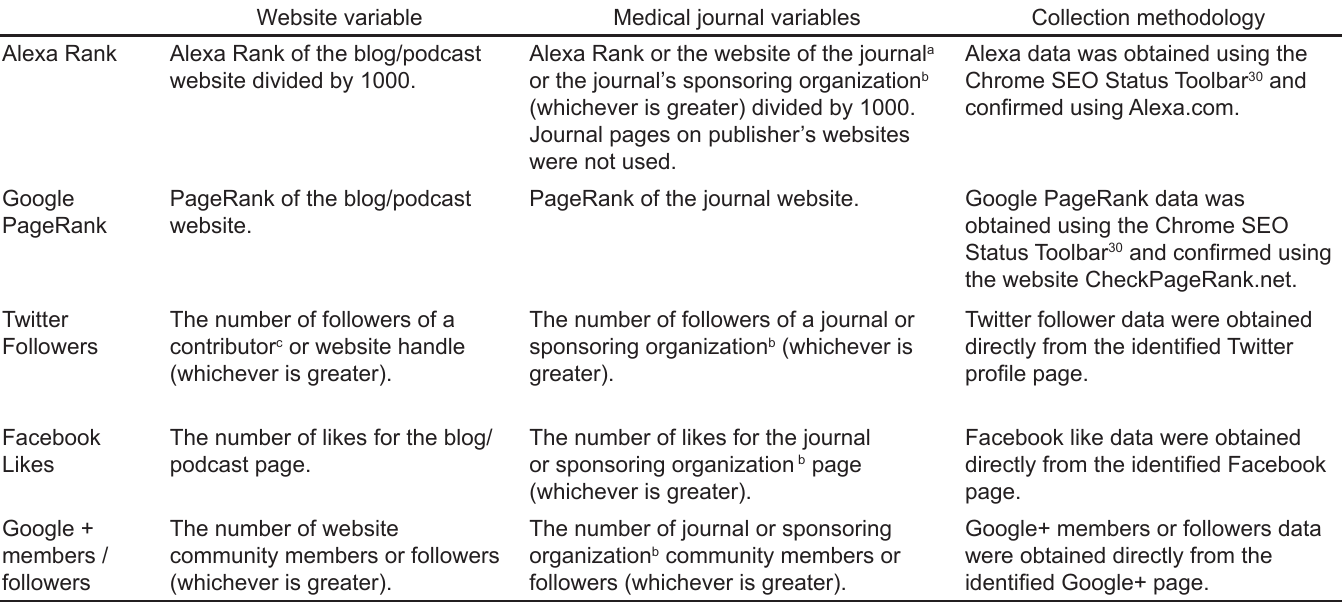
Table 1. Definitions of the variables considered for the Social Media